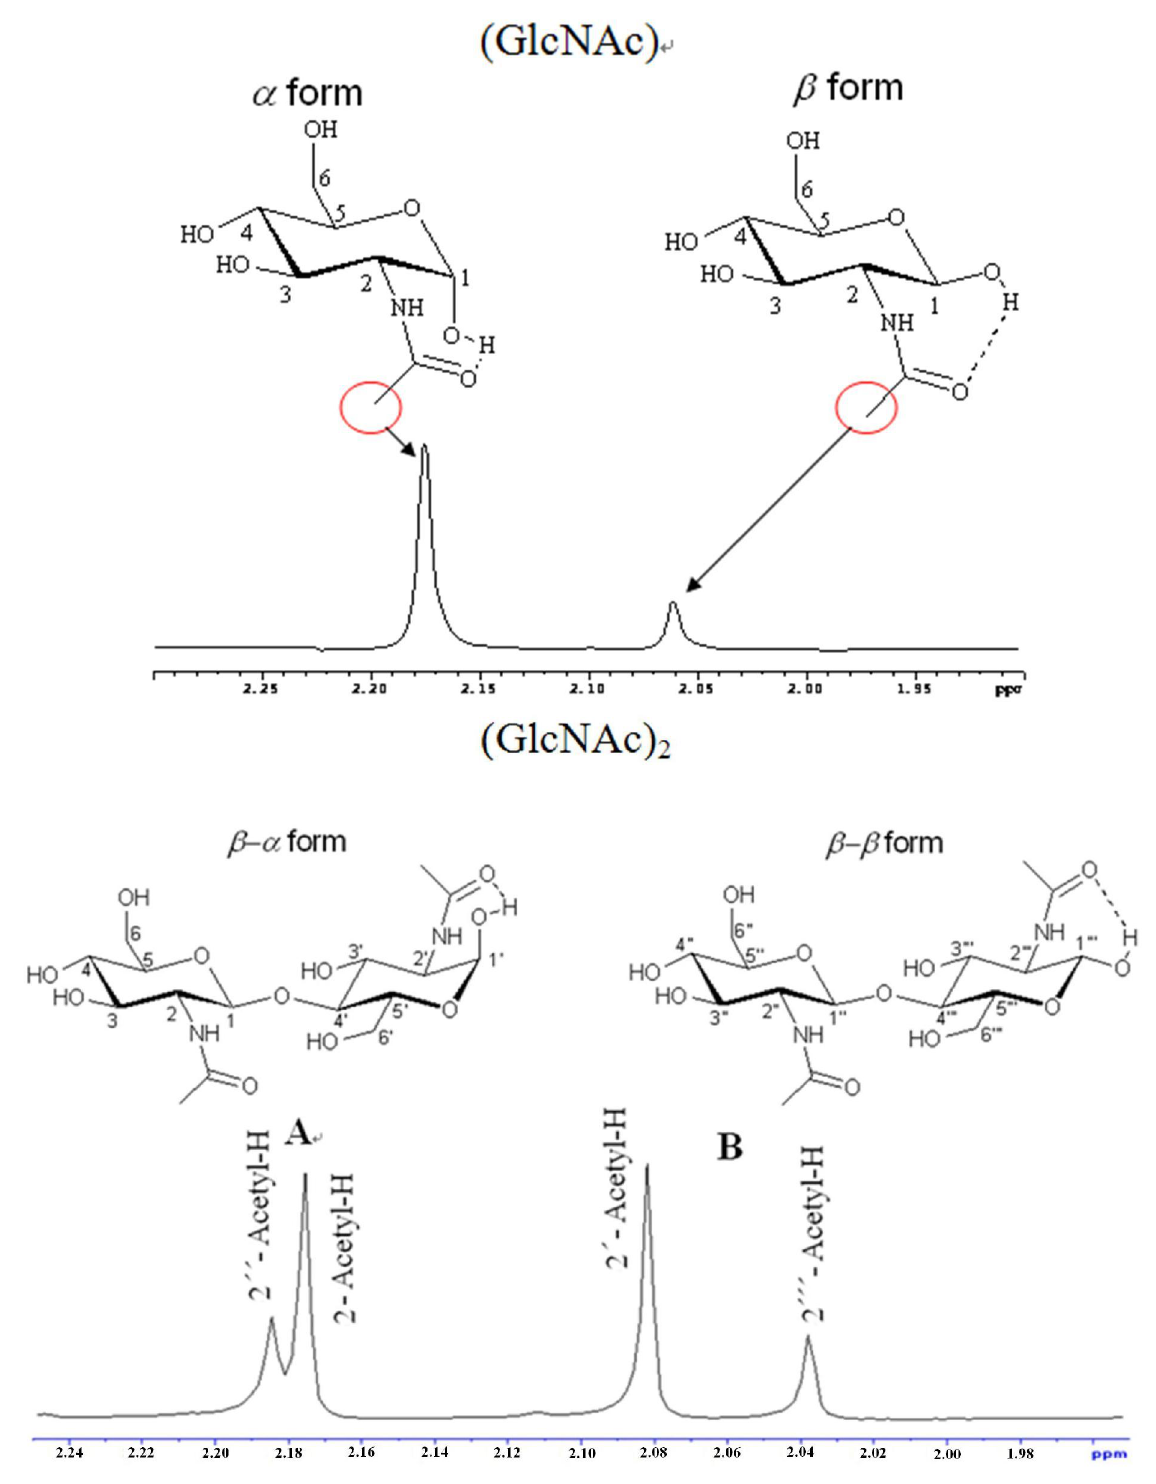
in pyridine- d 2 5